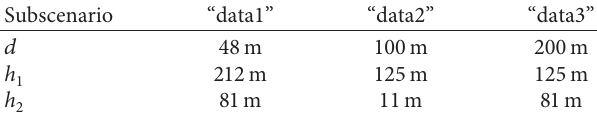
Table 2: Information on the tested